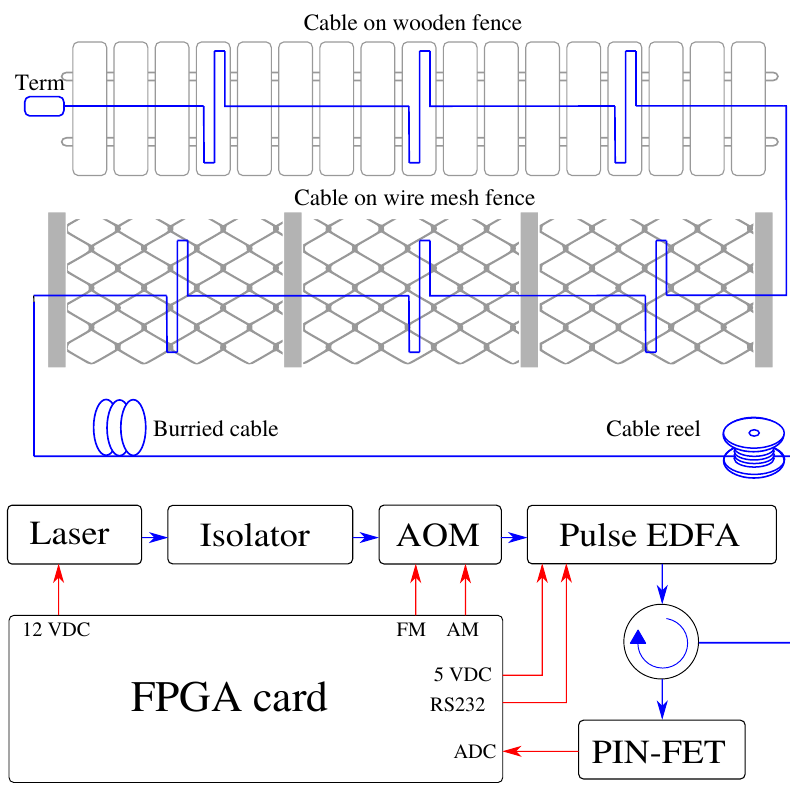
Figure 4. Scheme of a perimeter monitoring system based on Φ